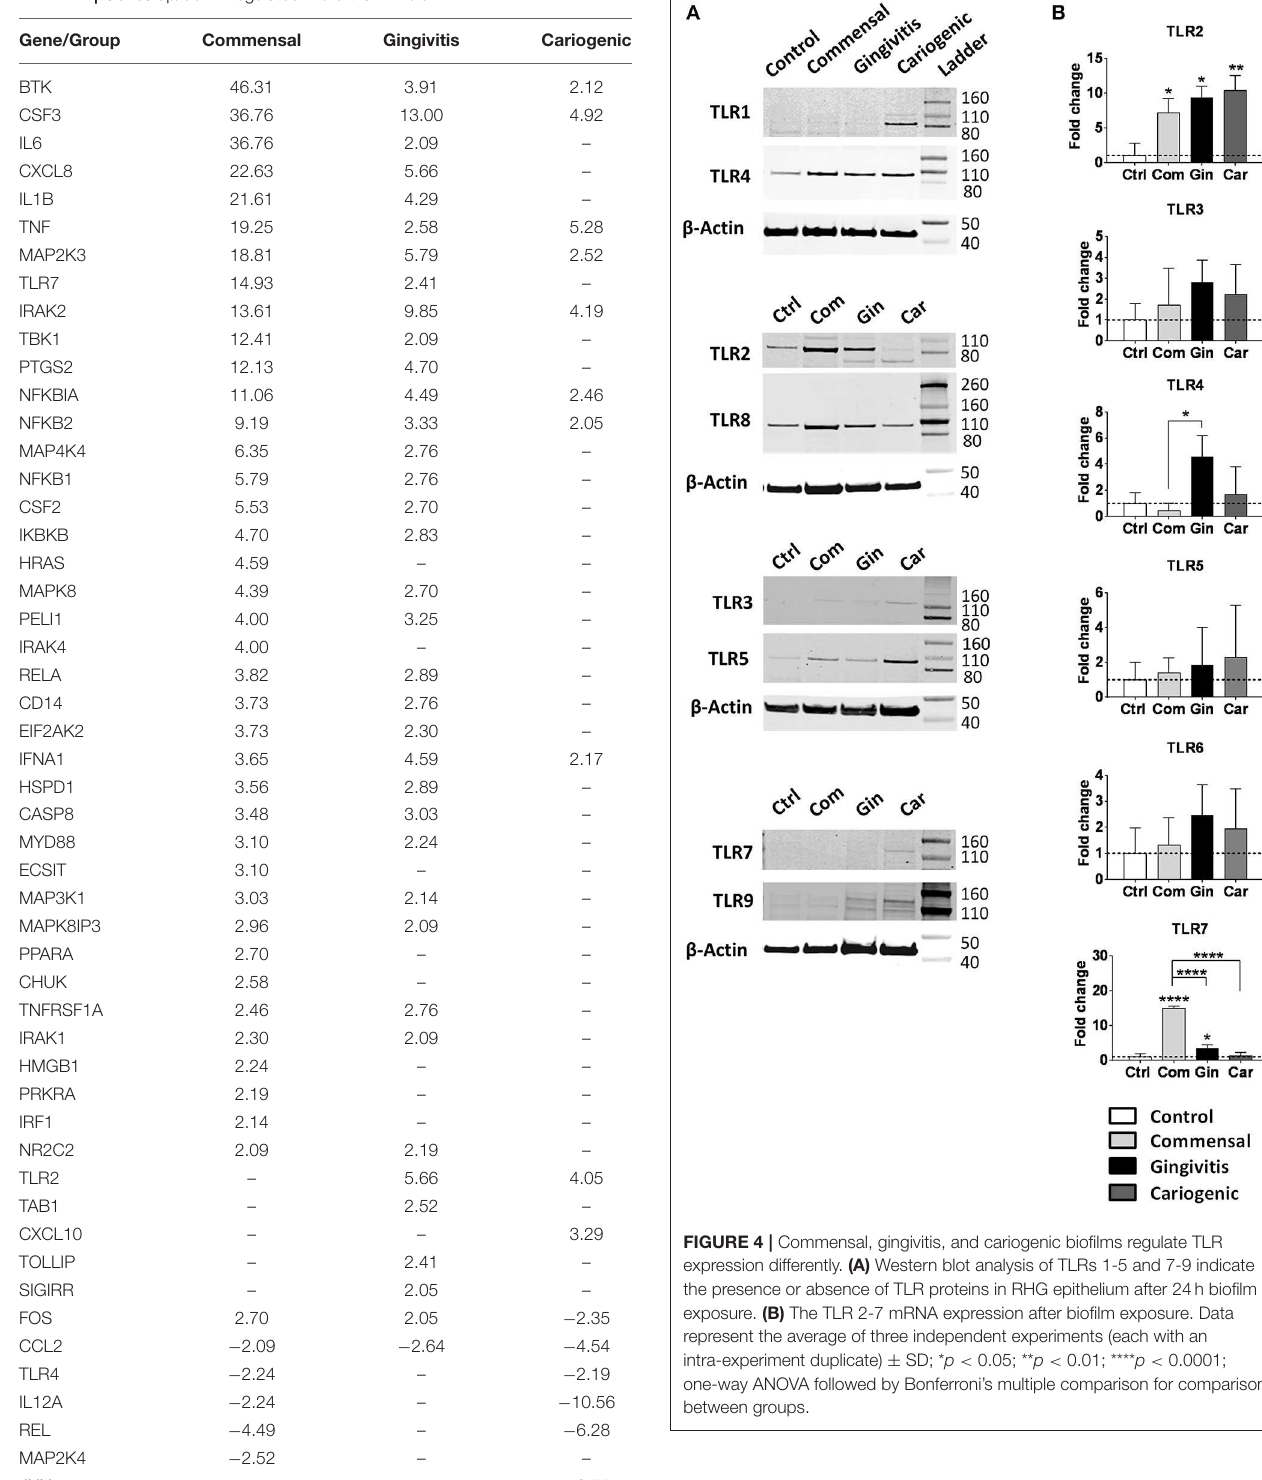
In the oral cavity, biofilms continuously adapt to their different habitats. For example in the gingival sulcus, there are three types of biofilms that may diverge from each other and in doing so influence the periodontal tissues differently: